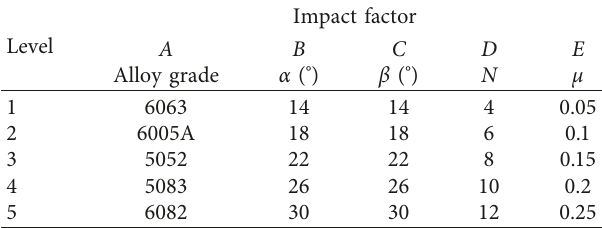
Table 3: Levels and impact factors of the orthogonal